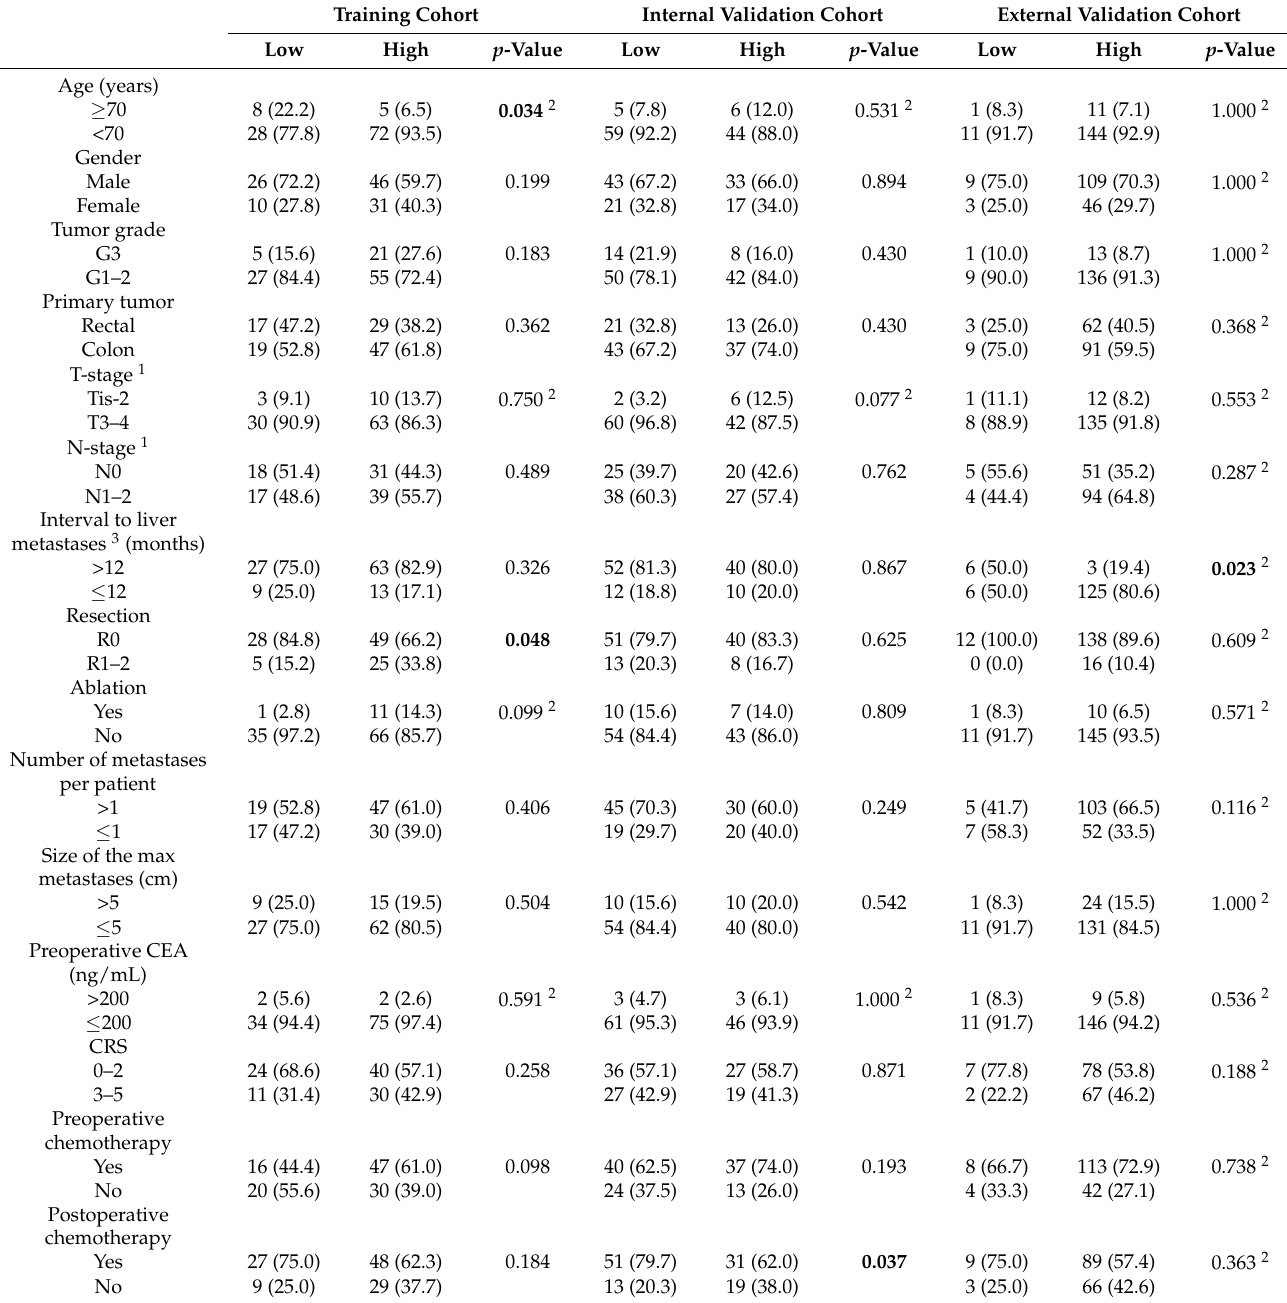
Table 1. Clinicopathologic characteristics of patients with colorectal cancer liver metastases in three